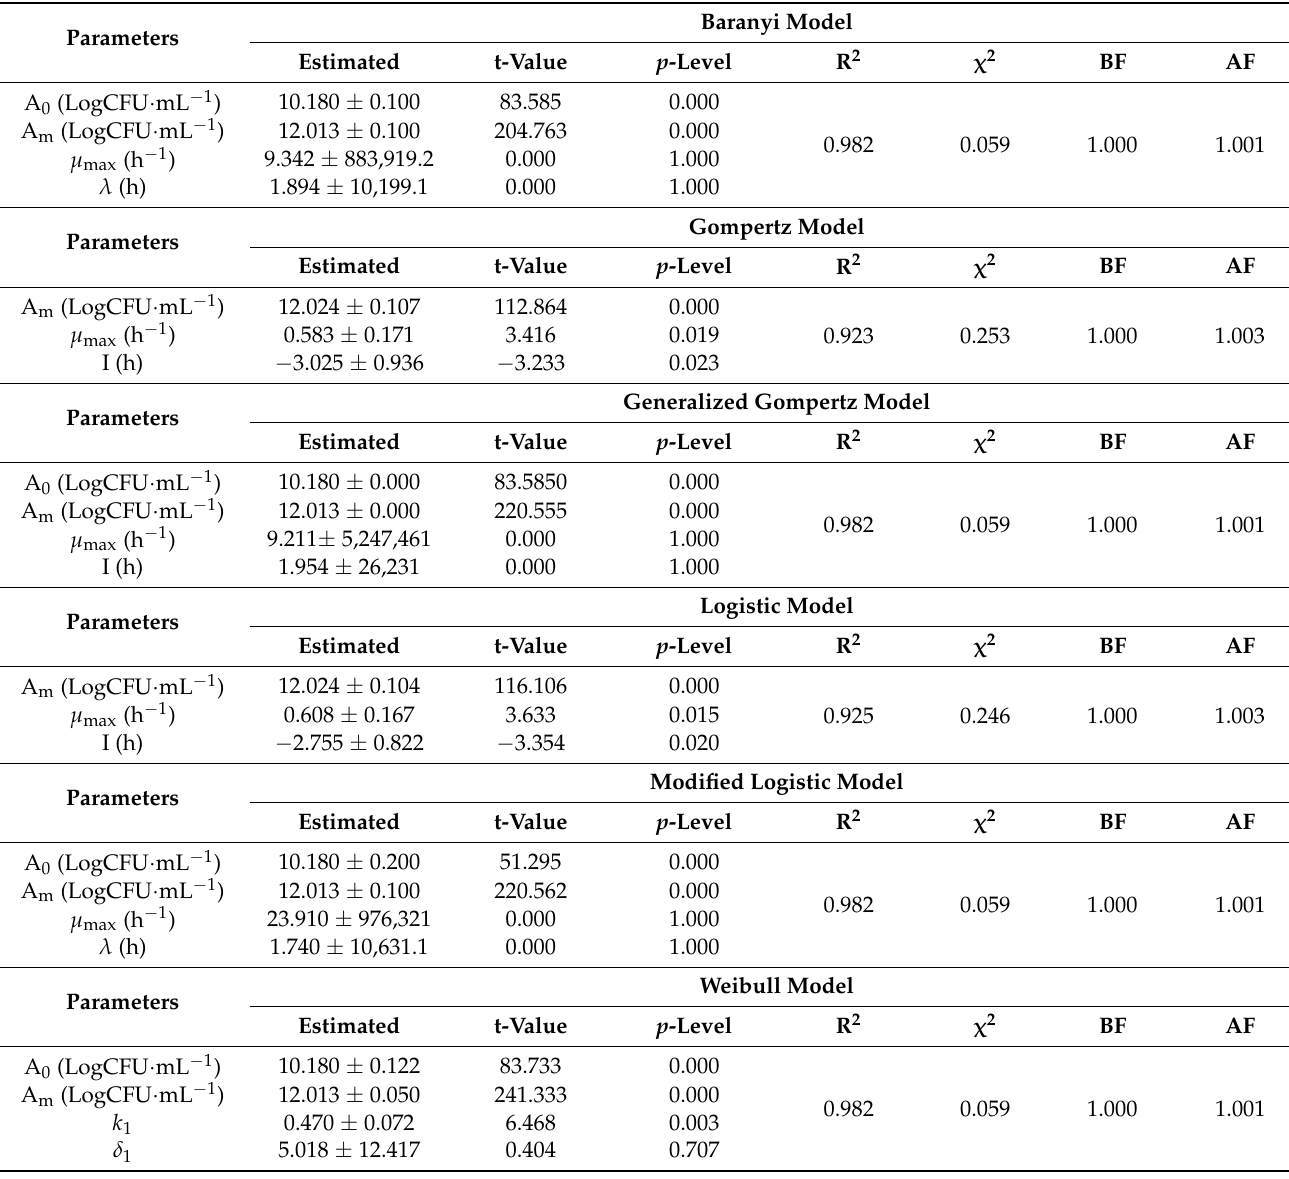
Table 3. Parameters of the models for the cell growth process in the filmogenic